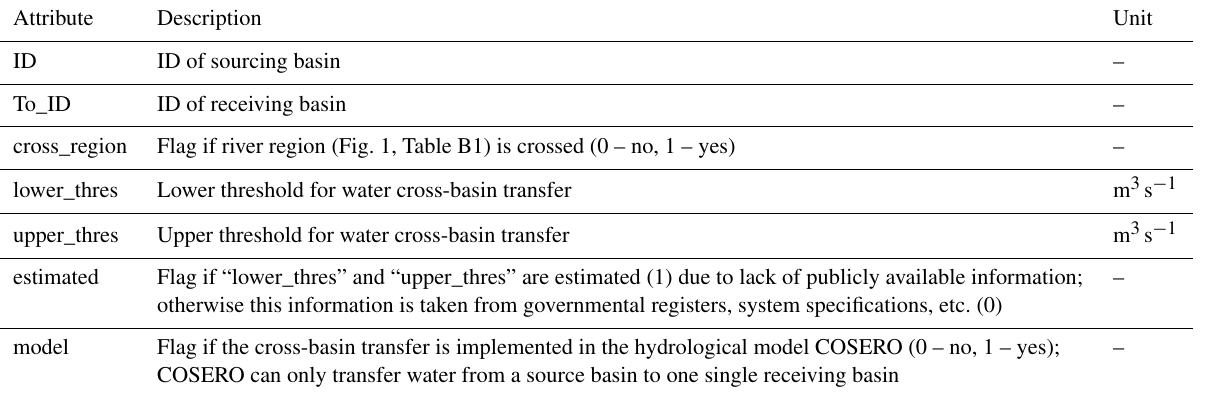
Table A11. Attributes in the accompanying file Crossbasin_water_transfers.csv. ∗